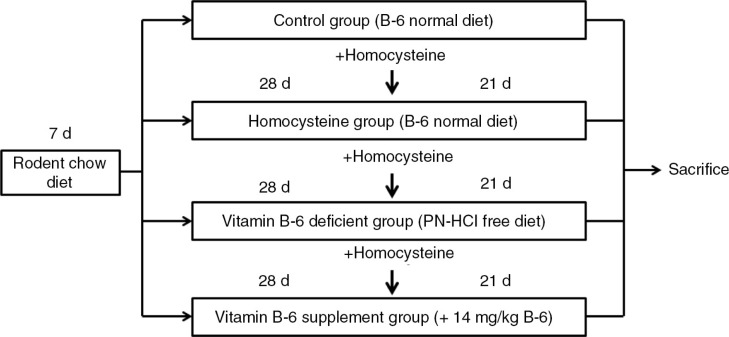
The study design.